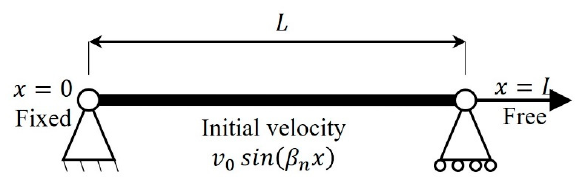
Figure 5. Problem statement of a 1D continuum bar vibration.